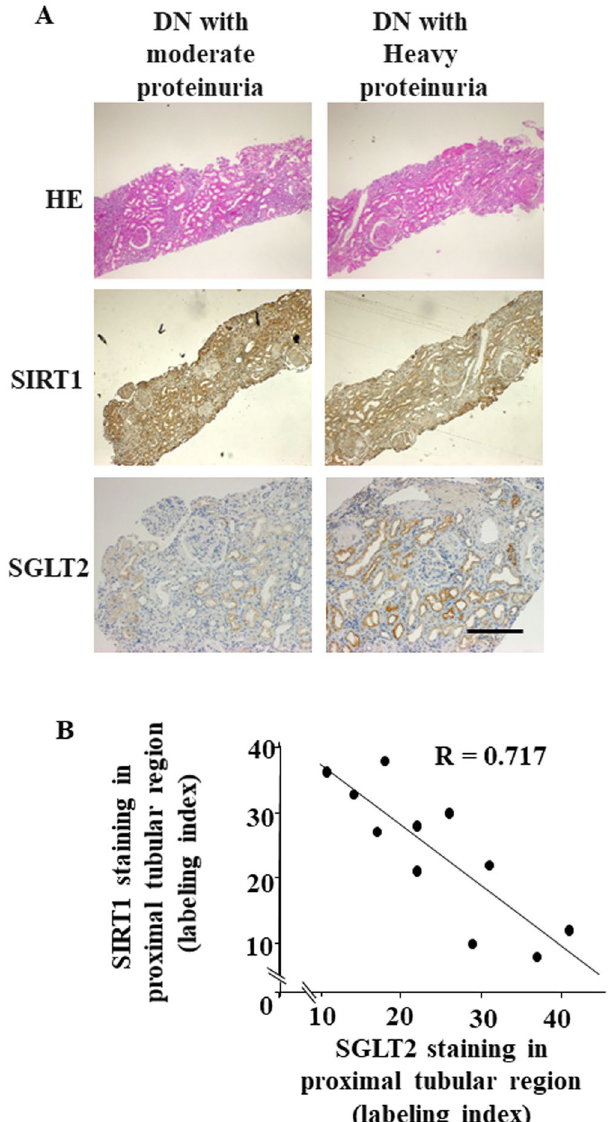
Figure 6. Immunohistochemical analysis of SIRT1 and SGLT2 expression in human renal biopsy specimens. ( A ) Representative photomicrographs of hematoxylin and eosin staining or immunostaining of SIRT1 and SGLT2 in renal needle-biopsy specimens of patients with diabetic nephropathy (DN) (DN-1 and -5, Table 1 for patient details). Scale bar, 50 nm. ( B ) The relationship between the intensity of immunostaining of SIRT1 and that of SGLT2 in the proximal tubular region in renal biopsy specimens from patients with DN, n = 11